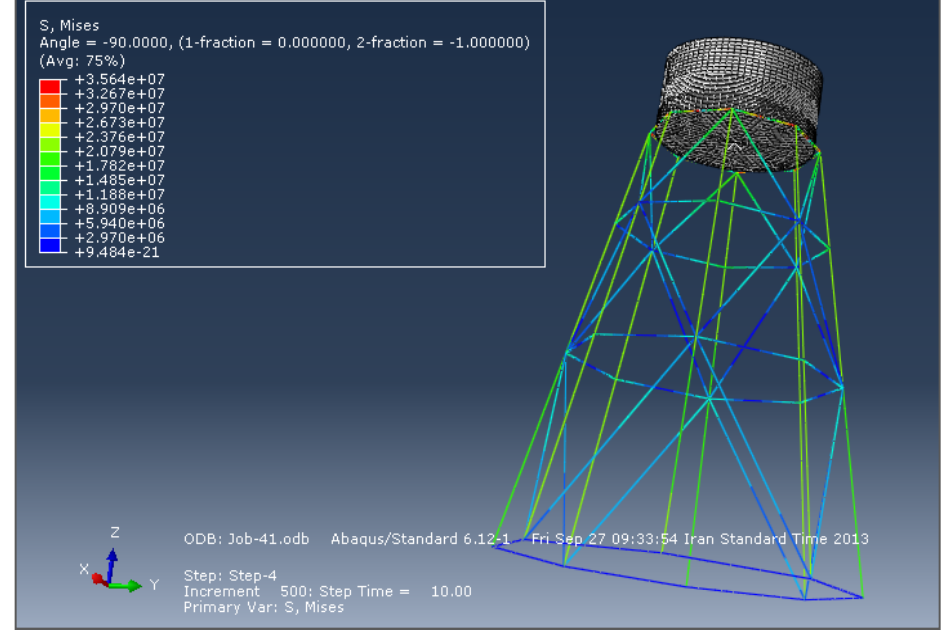
Figure 17. Stress in a rigid elevated storage tank equipped with an annular baffle.